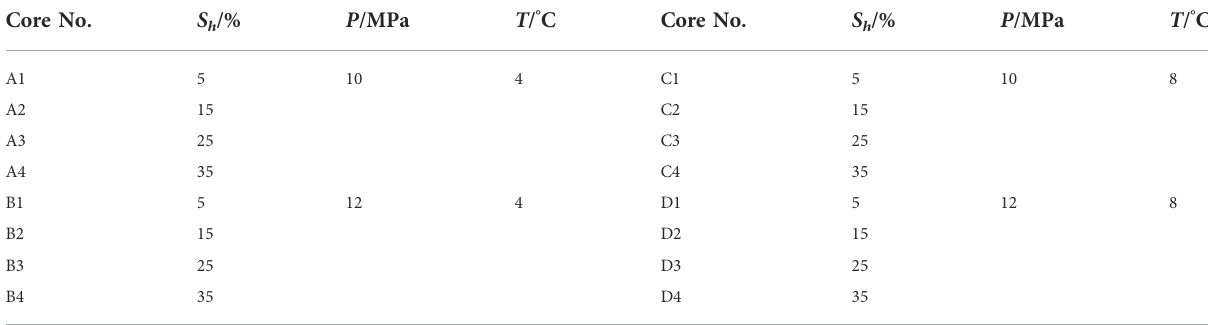
TABLE 3 The experimentalconditions for the preparation and mechanical test of hydrate-bearing sediments in the non-intrusive state. S h represents the hydrate saturation, P and T represent the pressure and temperature in the reactor respectively. Core No.